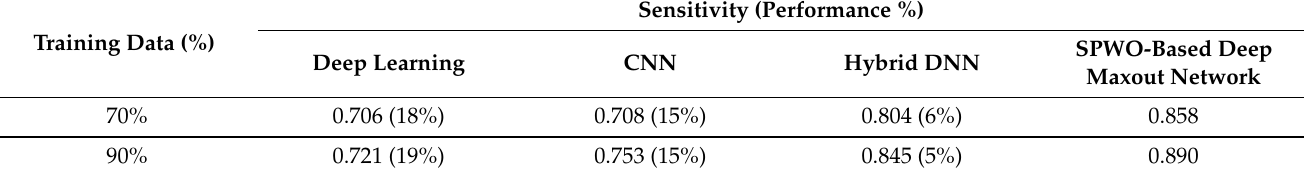
Table 4. Analysis with Sensitivity.